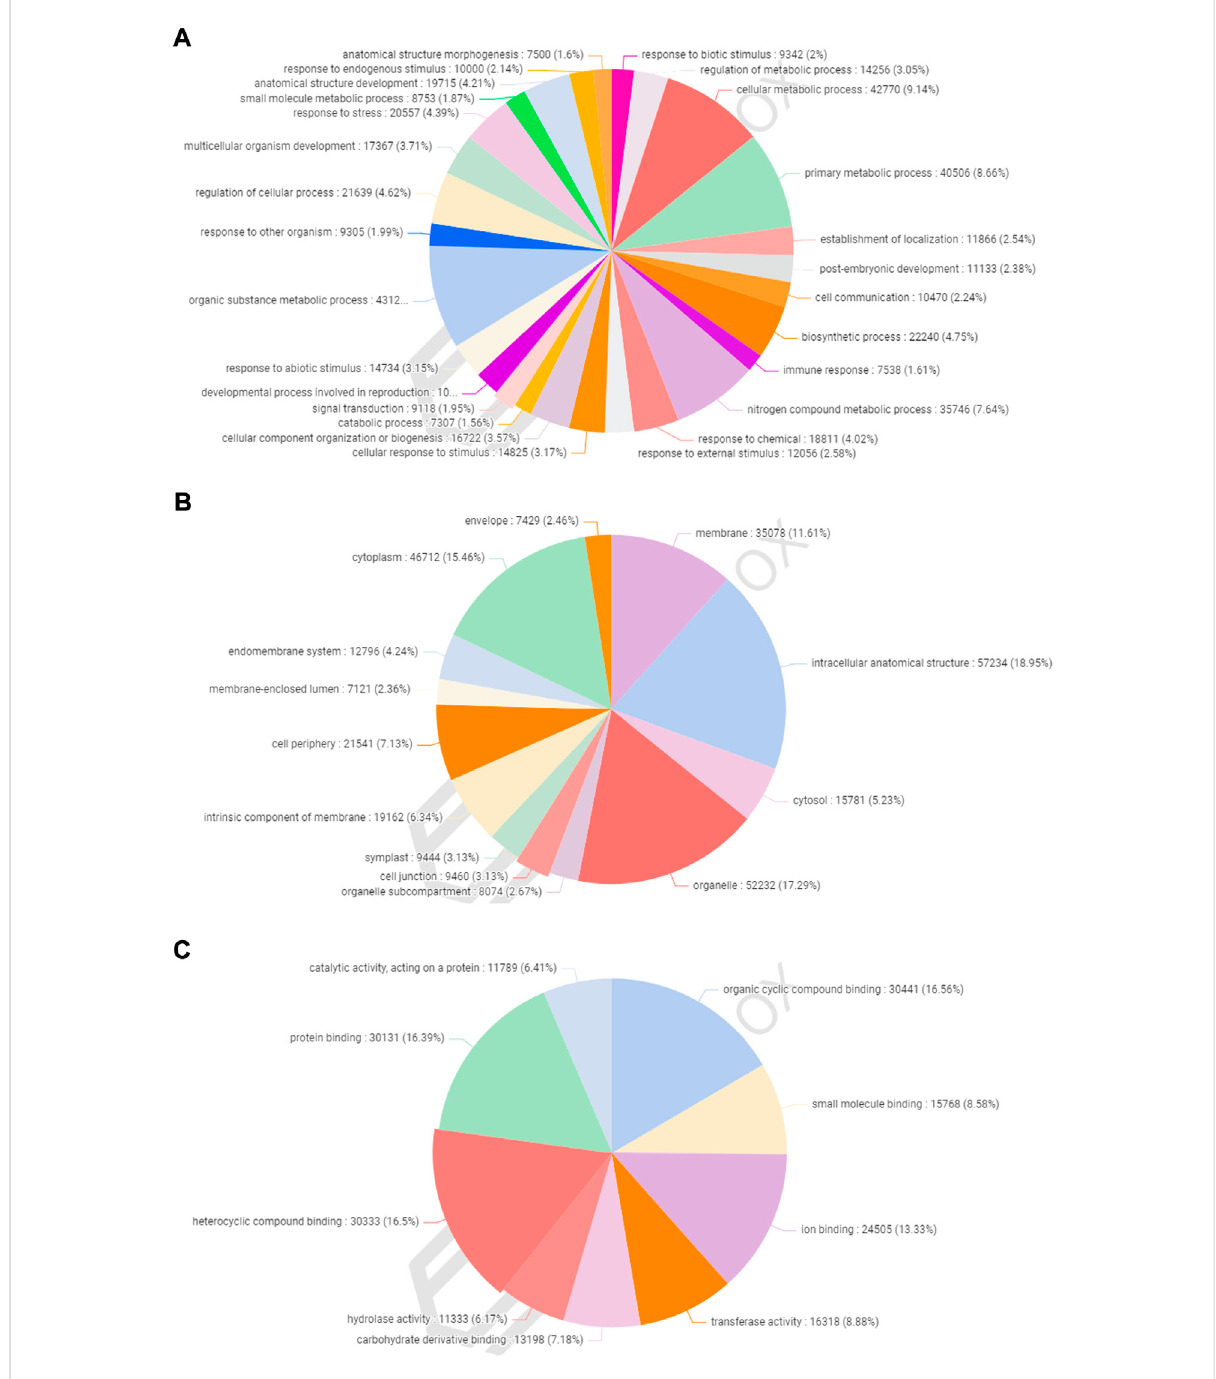
FIGURE 5 Functional classi fi cation of gene ontology (GO) terms under biological process (A) , cellular component (B) , and molecular function (C) categories.